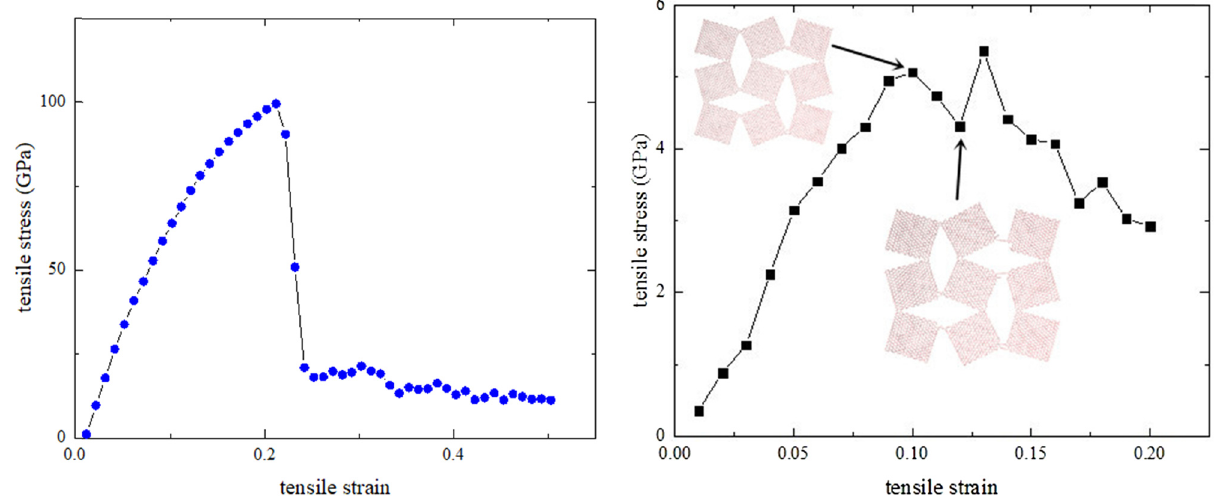
Figure 3: Stress – strain curves of single - layer perfect graphene: the size is 3 nm × 3 nm.